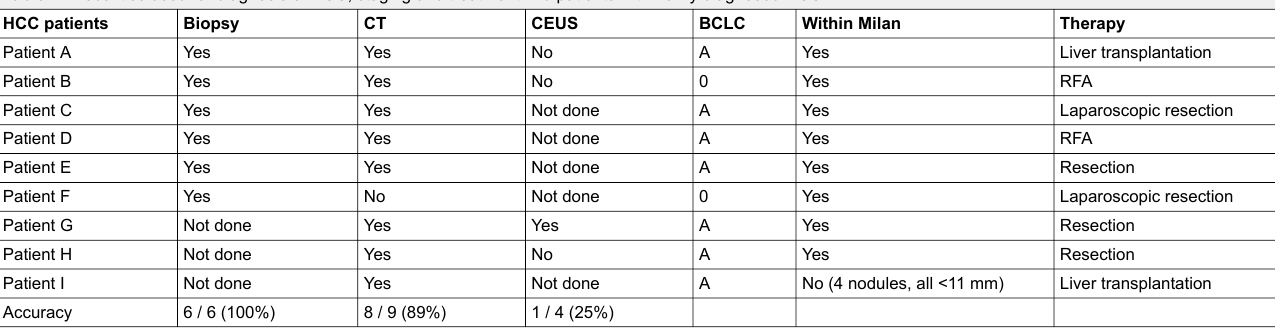
Table 1: Modalities used for diagnosis of HCC, staging and treatment in 9 patients with newly diagnosed HCC. HCC